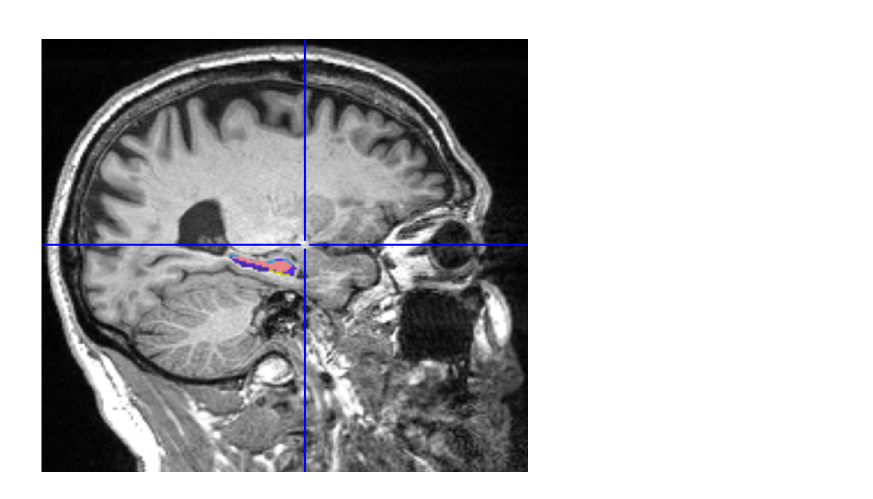
Figure 3. Winterburn segmentation protocol obtained from volBrain.